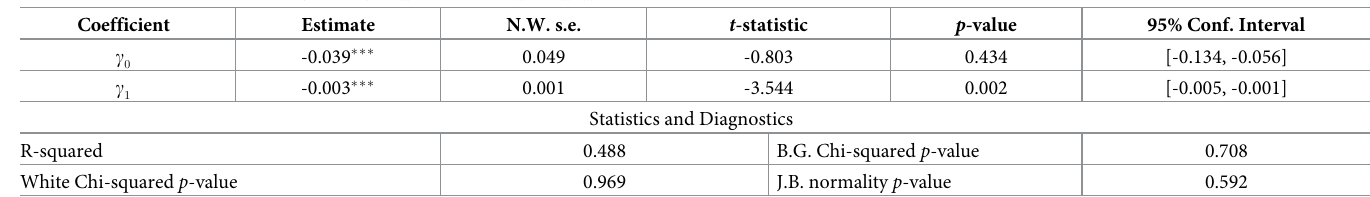
(cid:0) ^ b ^ before Þ ¼ γ þ γ ð S t � (cid:0) S t � Þ þ u (Hypothesis 1 ; m 1 ; m 0 1 m m m m m